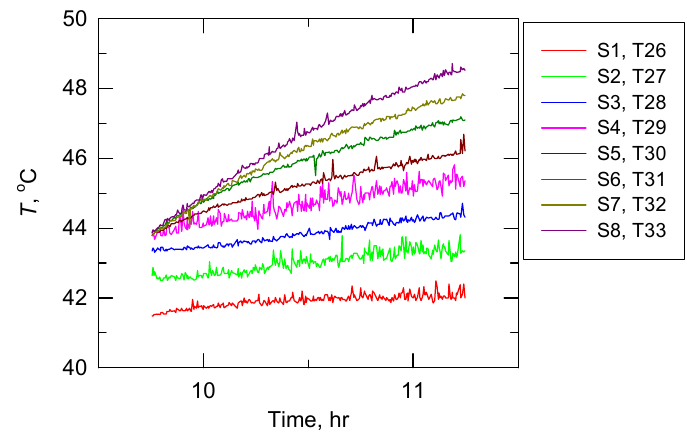
Figure 8. Outlet temperature variation of SWHs, 10 LPM